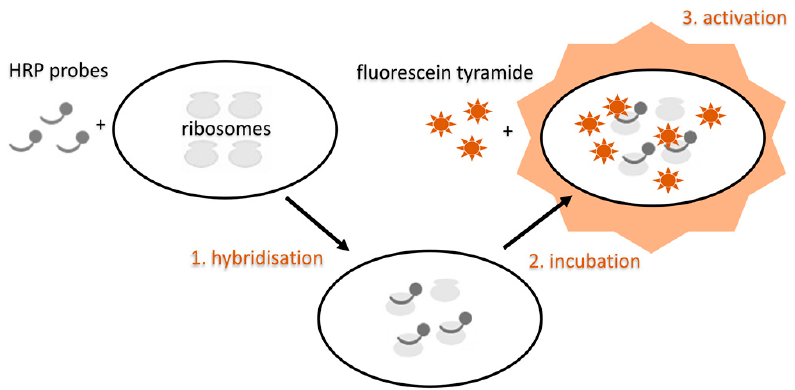
Figure 7. Scheme of tyramide signal amplification FISH in a bacterial cell. 1. hybridization with HRP-labelled probe. 2. incubation with fluorescein tyramide. 3. The activation of fluorescein tyramide and its binding to the cell’s electron-rich compartments, leading to fluorescence (modified from [128].